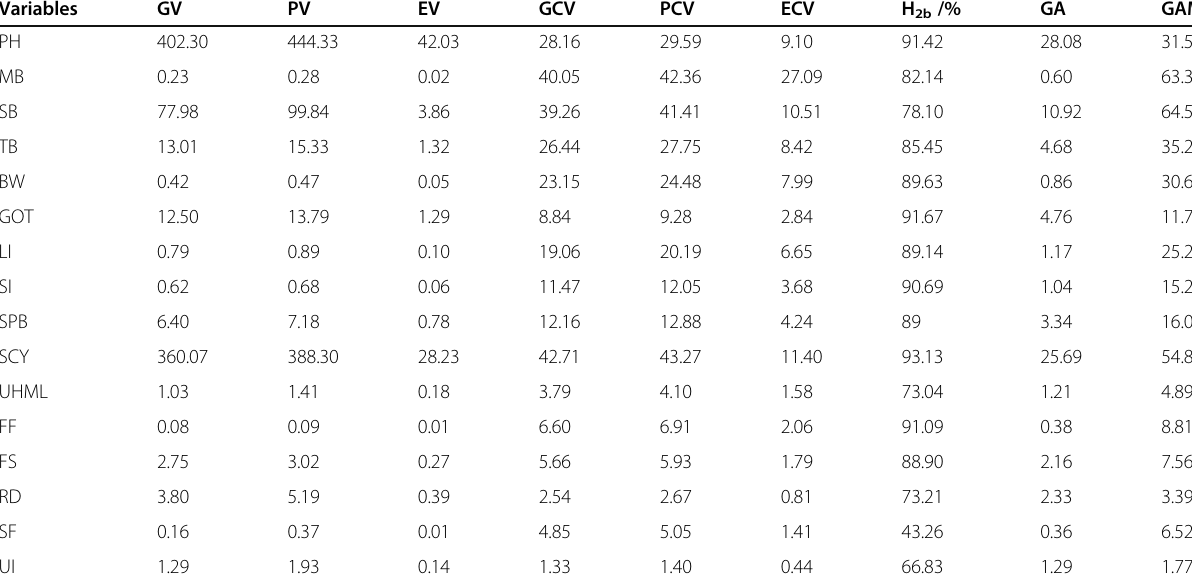
Table 4 Estimation of parameters of genetic variability and heritability Variables